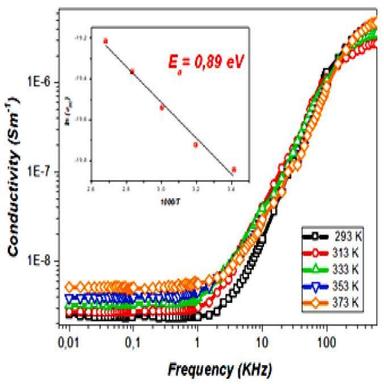
The variation of the conductivity as a function of frequency at different temperatures for ITO/M-DSB/Al device. Inset: showing the variation of the log (σdcT) as a function of (1000/T).